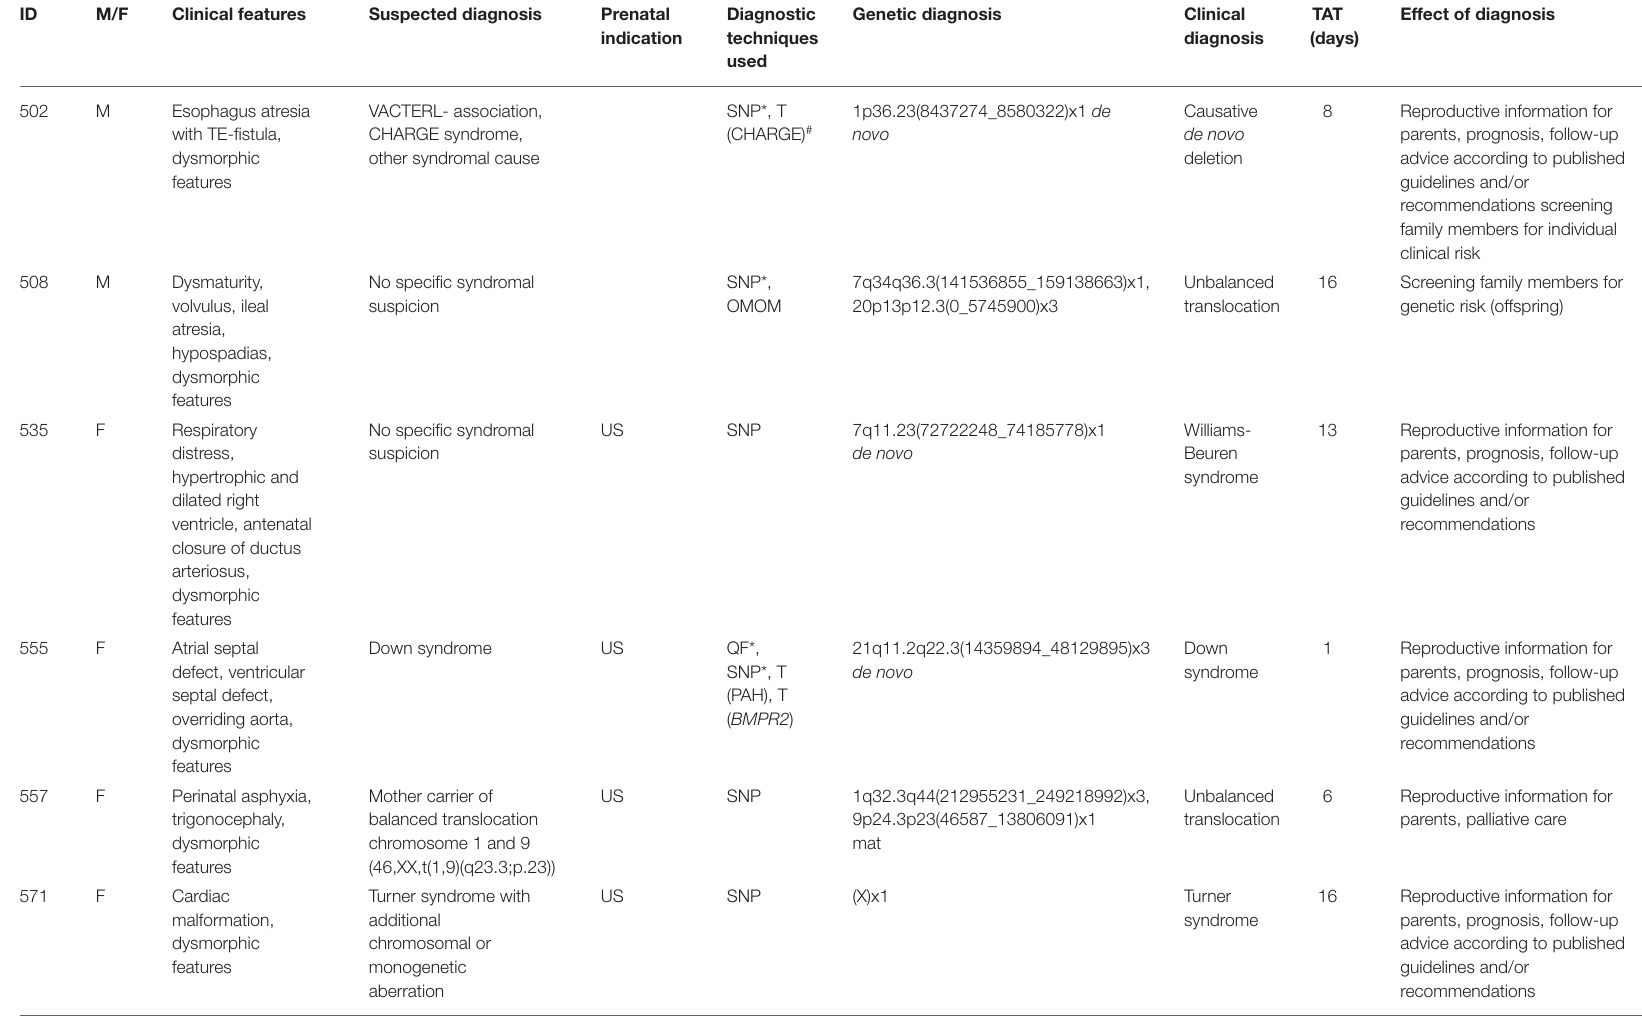
TABLE 3 | Diagnoses made with